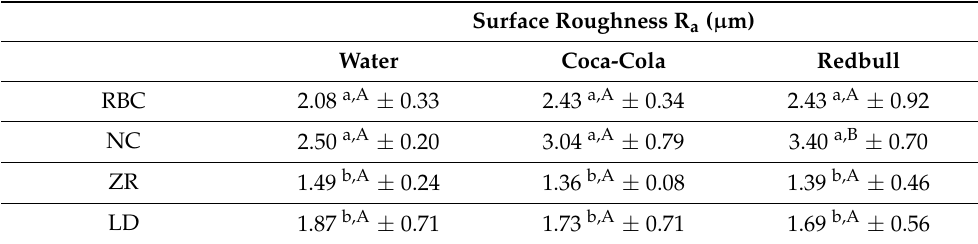
Table 3. Surface roughness, expressed as mean ± standard deviation, for all the tested subgroups. Same superscript capital letters indicate no difference between row results. Same superscript lower- case letters indicate no difference between column